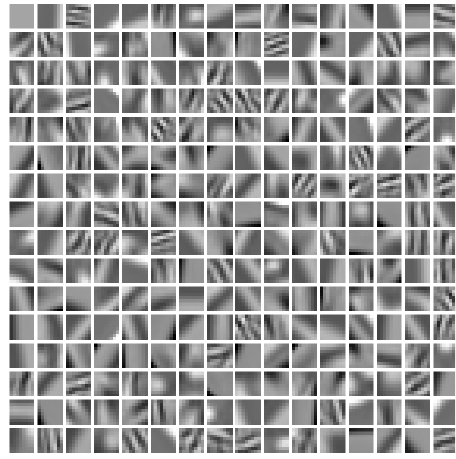
Figure 5. The dictionary trained using Figure 4.